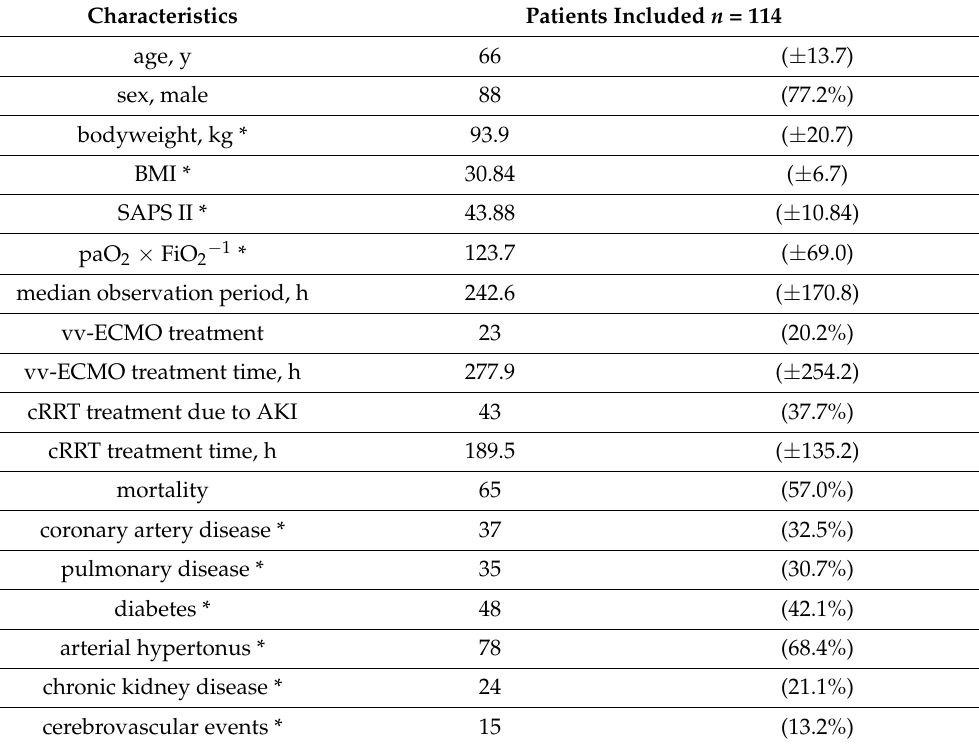
Table 1. Clinical characteristics of CARDS